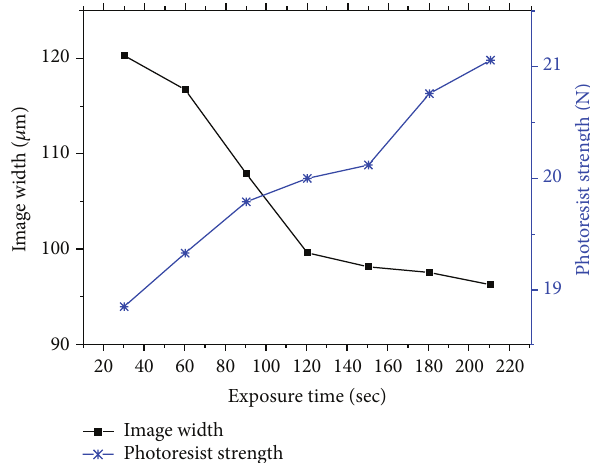
Figure 4: Effect of exposure time on image width and photoresist film